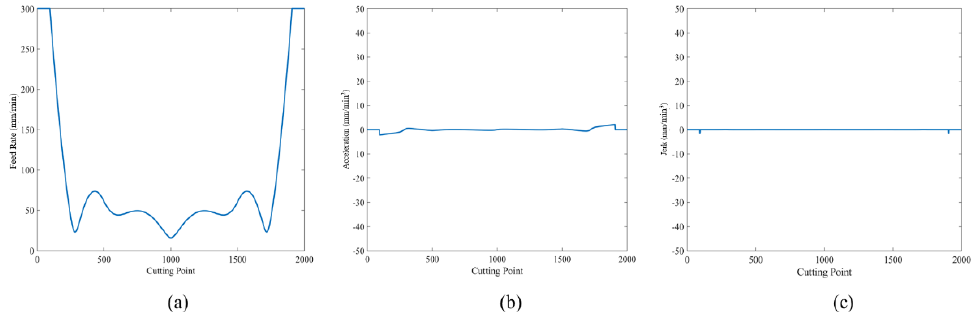
Figure 19. Cutting trident shape using method by Yeh and Hsu [10]: ( a ) feed rate, ( b ) acceleration, and ( c ) jerk.